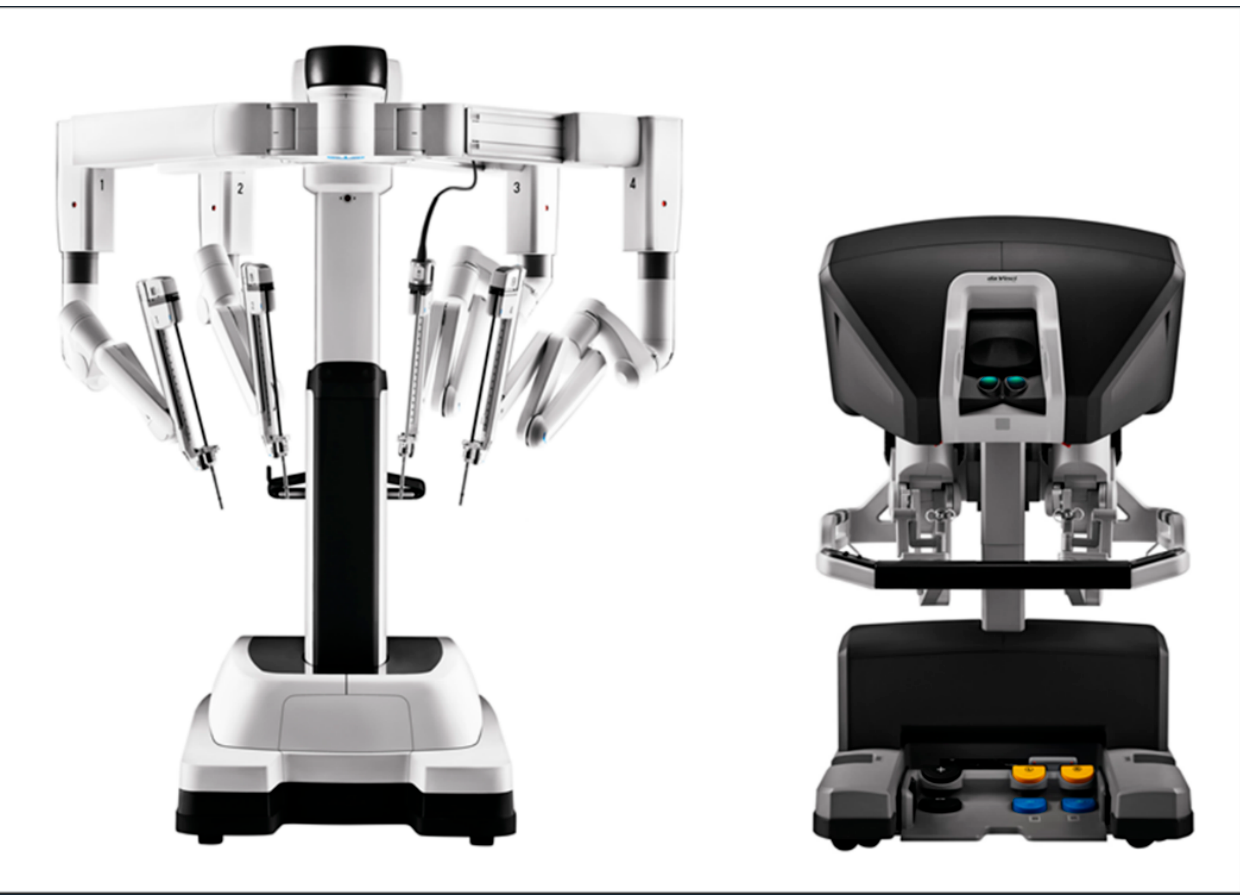
Figure 1. DaVinci Xi ® . Multi-port robotic system with camera arm and several working arms for the use of different surgical instruments. Reproduced with kind permission from Intuitive Surgical ® , Inc., Sunnyvale, CA, USA, © 2021.